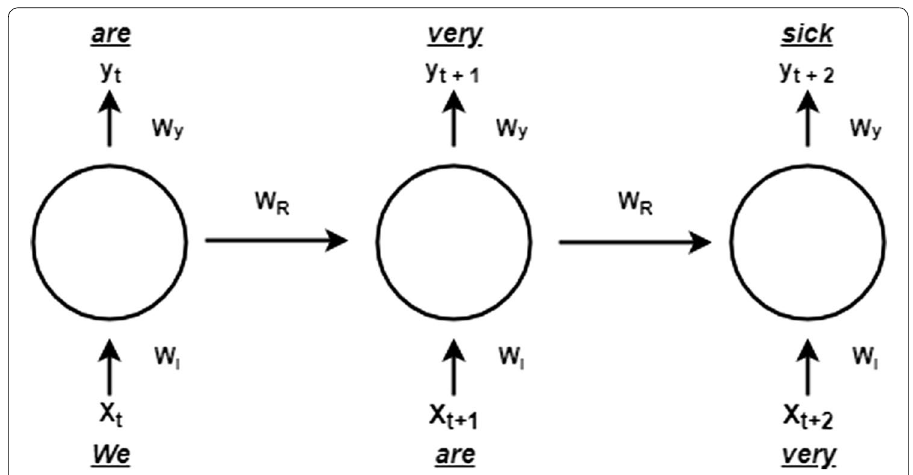
Fig. 5 Recurrent neural